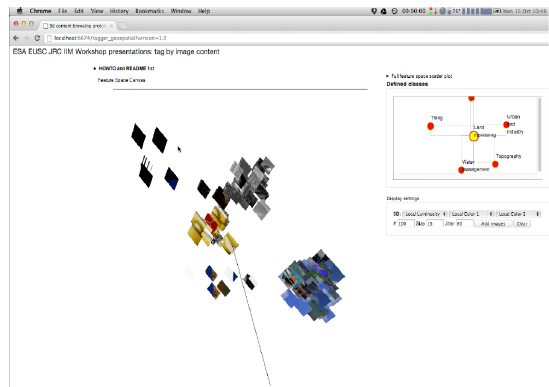
Figure 2: UI based on 3D image tile gallery: User interaction for the selection of elements of interest requires complex navigations skills in a high dimensional space. 2D interfaces are easier to use.